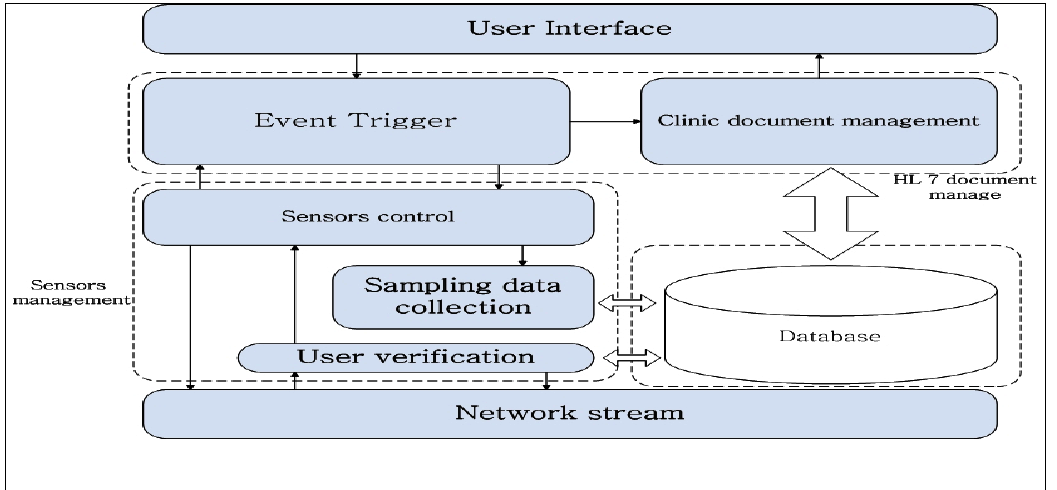
Figure 5. Monitoring software